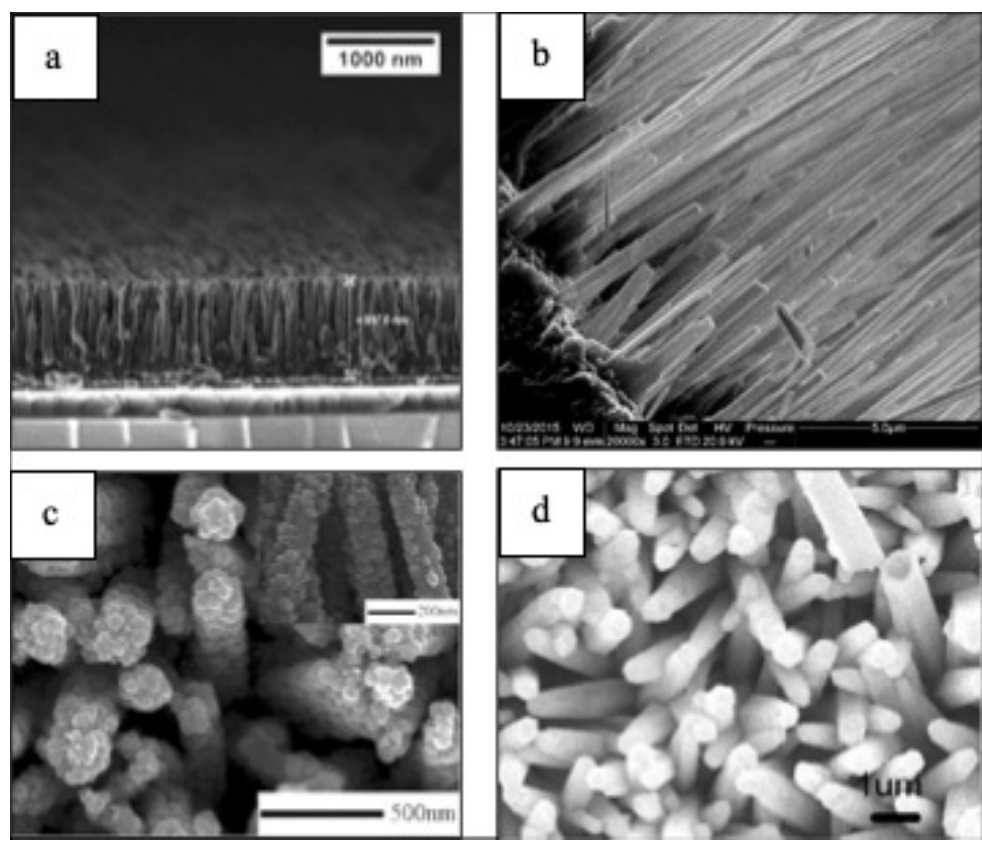
Figure 7. SEM characterization of ( a ) Bi:Al 21:1 photocathode [100], ( b ) CuO NWs [101], ( c ) Hydro- genated TiO 2 /ZnO heterojunction (TZ10-H) [102], and ( d ) ZnO/CdS/Au NTAs [103]. Reproduced with permission from references [102–105].